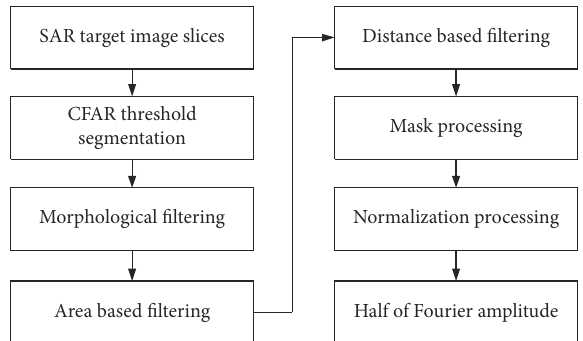
Figure 4: Flowchart of the SAR preprocessing